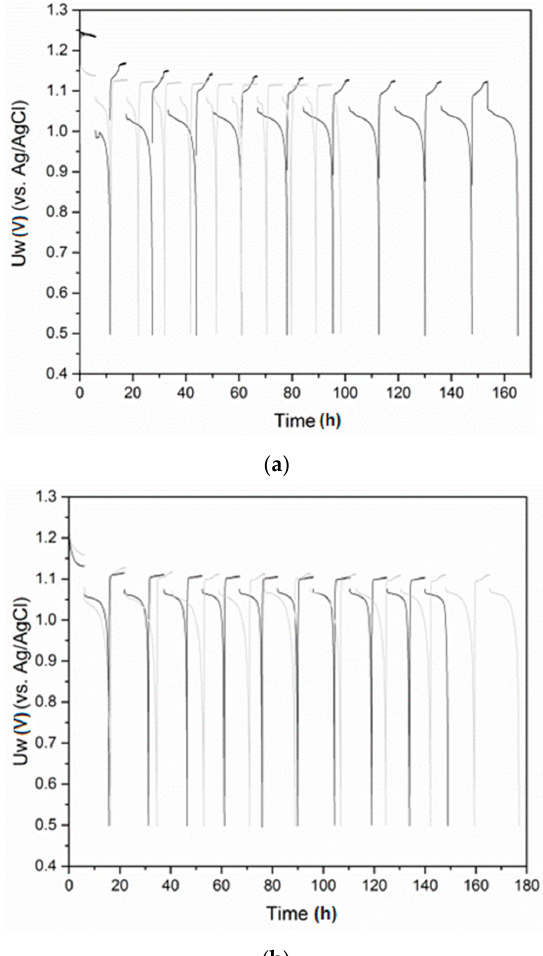
Figure 4. First 10 cycles for LaNi 5 based alloys at current density of 5 mA during charge and 2 mA during the discharge. LaNi 4.3 Co 0.4 Al 0.3 (black) and LaNi 5 (gray) ( a ). LaNi 4.8 Sn 0.2 (black) and LaNi 4.7 Sn 0.3 (gray) ( b ).